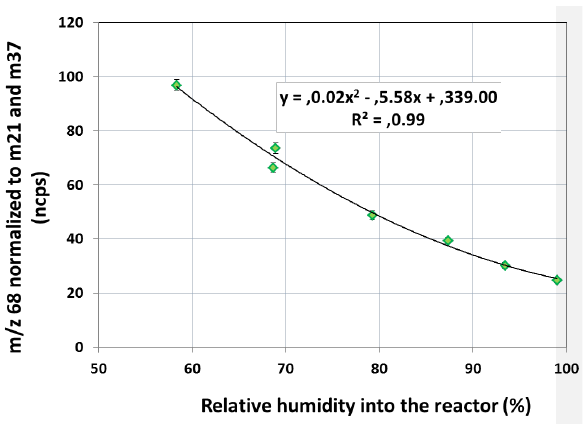
Figure 34. Change in the pyrrole signal (m/z 68) for different percentage of relative humidity 2 into the setup. The temperature of the setup is maintained constant at 24°C 3 Fig. 4. Change in the pyrrole signal ( m/z 68) for different percent- age of relative humidity into the setup. The temperature of the setup is maintained constant at 24 ◦